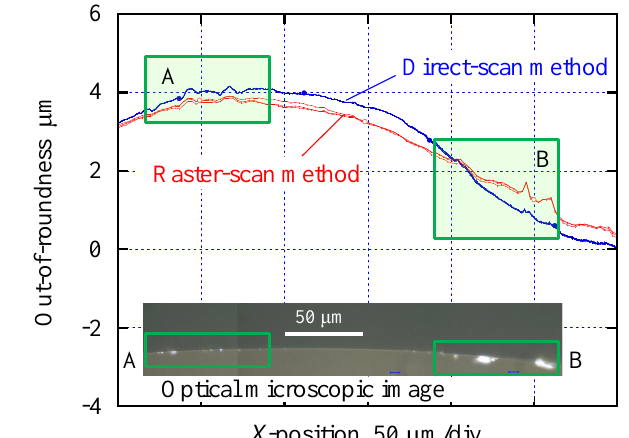
Figure 18. Comparison between the raster-scan method and the direct-scan